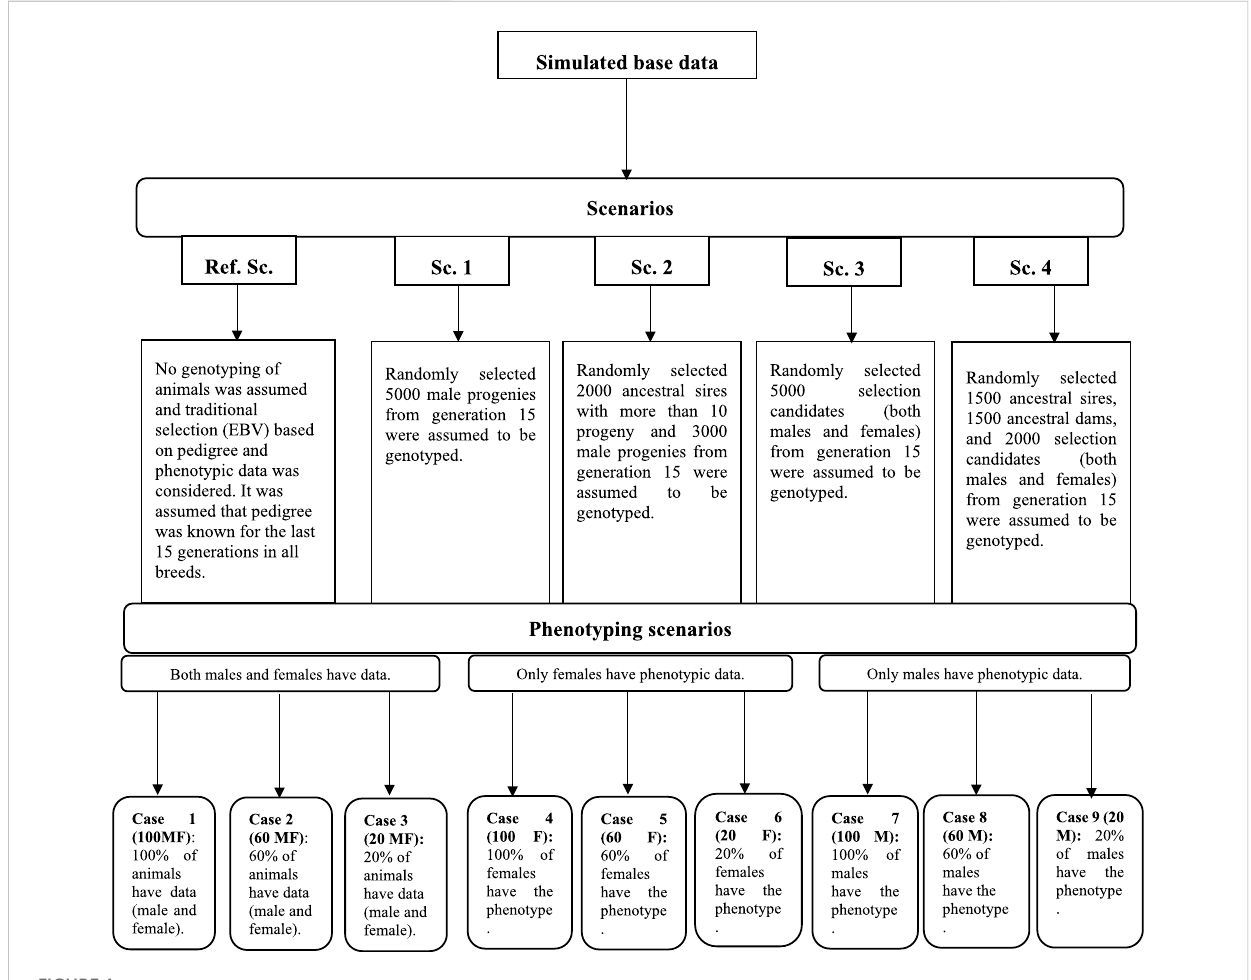
FIGURE 1 Schematic representation of the genotyping and phenotyping